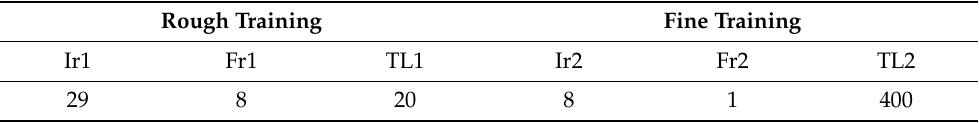
Table 4. SOM training parameters.